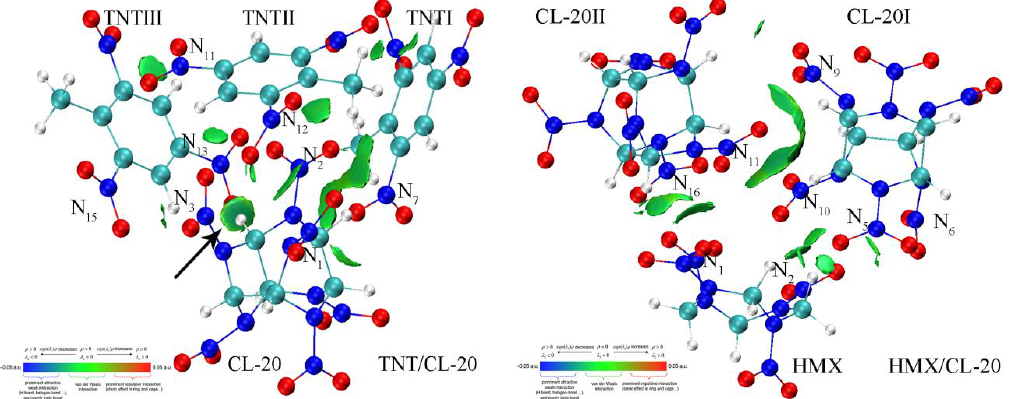
Figure 5. Intermolecular non-covalent interactions between TNT and CL-20 ( left ) and between HMX and CL-20 ( right ). The interactions between CL-20 and TNT (HMX) are presented. Carbon (C), oxygen (O), nitrogen (N), and hydrogen (H) atoms are represented by blue-green-, red-, blue- and white-colored balls, respectively. Only those nitrogen atoms in nitro groups that have interactions with others are numbered.